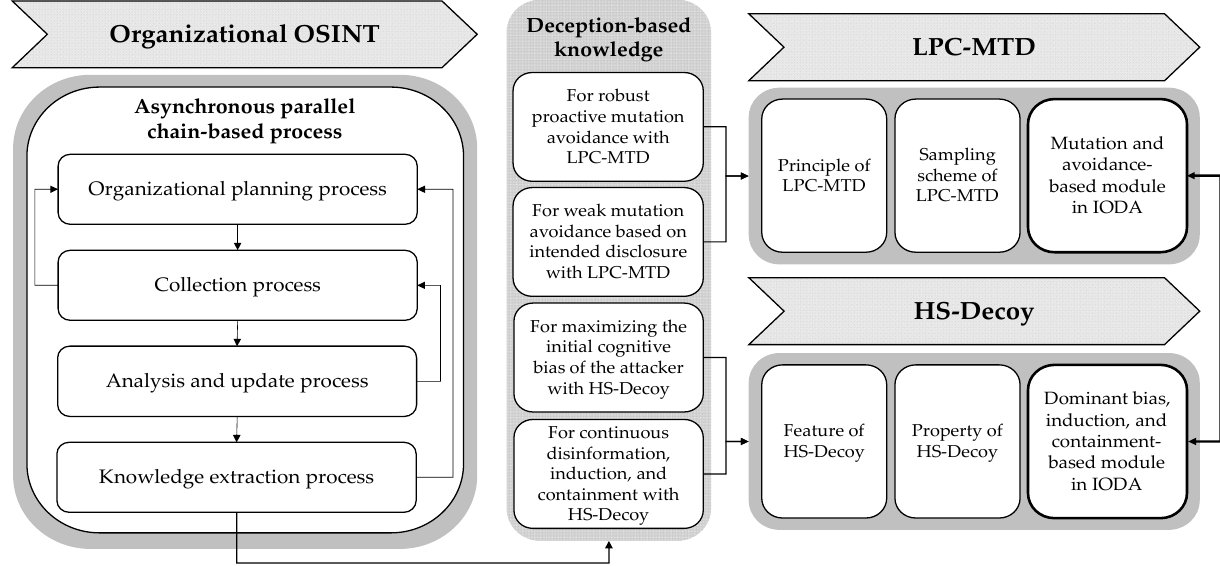
Figure 1. Main overview of the proposed open-source intelligence (OSINT)-based deception model with organizational OSINT, loosely proactive control-based MTD (LPC-MTD), and hierarchical social engineering decoy (HS-Decoy).